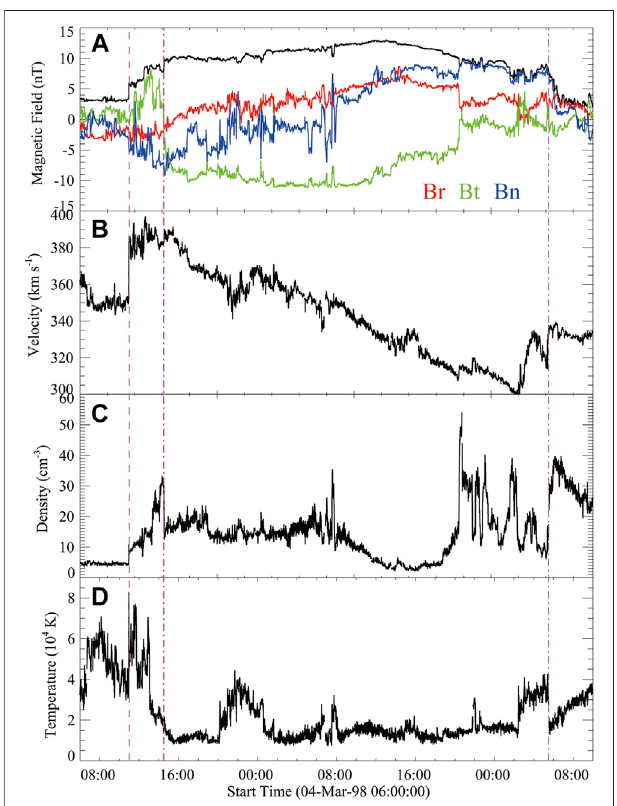
FIGURE2| Magnetic fi eldandsolarwindparameters measured byACE near 1 AU. (A) Total magnetic fi eld strength (black) and its three components in RTN coordinate and (B – D) velocity, density, and temperature of solar wind. The vertical dashed line denote the shock, and the dash-dotted lines demarcate the MC